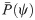
Box plots showing the correlation coefficients between P¯(ψ) and −Ψ¯′(ψ) calculated by generating a random phase response functions Z(θ) with differing number of harmonics.